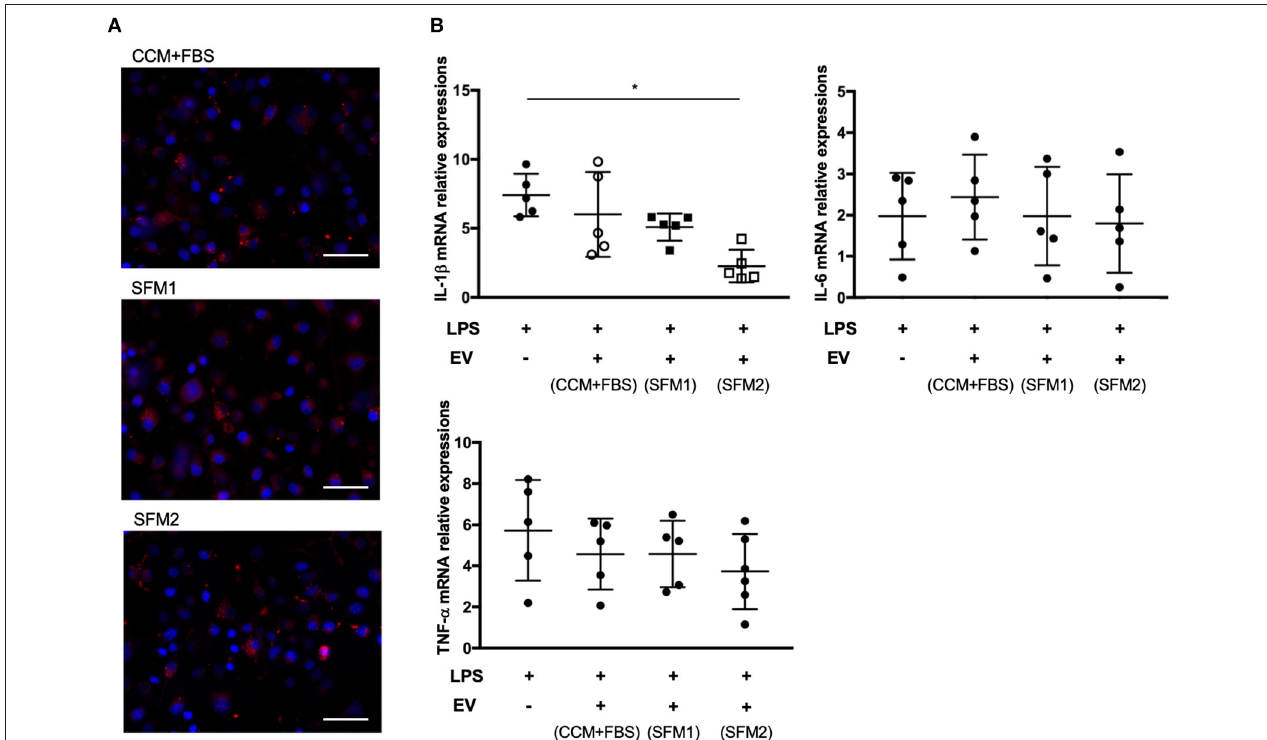
FIGURE 5 | Anti-inflammatory effect of MSC-derived EVs on BV-2 microglia cells. (A) Representative fluorescence microscope image showing the internalization of PKH26-labeled EVs (red) by BV-2 microglial cells. Bars = 50.0 µ m (B) qRT-PCR assay for the expression of IL-1 β , TNF- α , and IL-6 in BV-2 microglial cells incubated with lipopolysaccharide (LPS) and canine MSC-derived EVs from CCM + FBS, SFM 1 and SFM 2. Individual PCR reactions were normalized against the internal control GAPDH . (* p < 0.05) The levels of gene expression in non-LPS treated BV-2 cells were expressed as